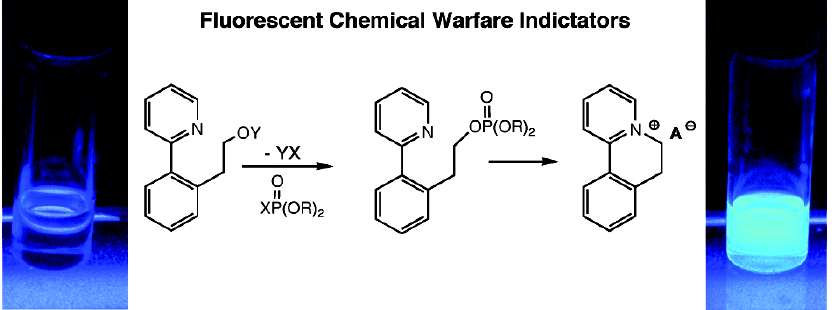
Figure 6. Schematic representation of the chemosensor developed by Zhang and Swager [49]. Reproduced with permission from reference [49], published by American Chemical Society,